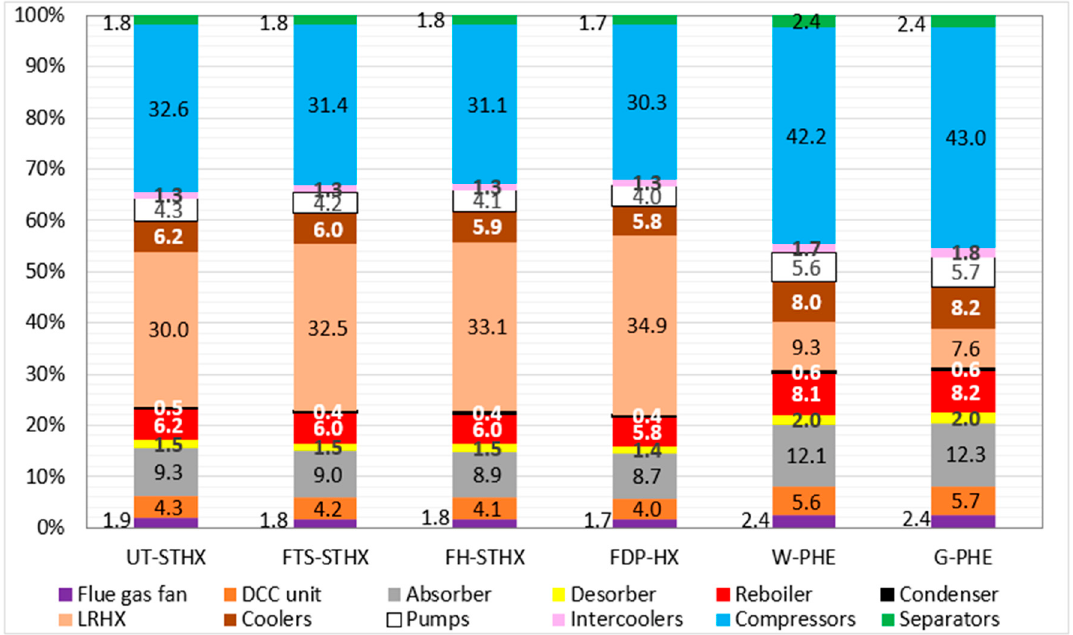
Figure 7. Contribution of each equipment to the CAPEX of the di ff erent scenarios.